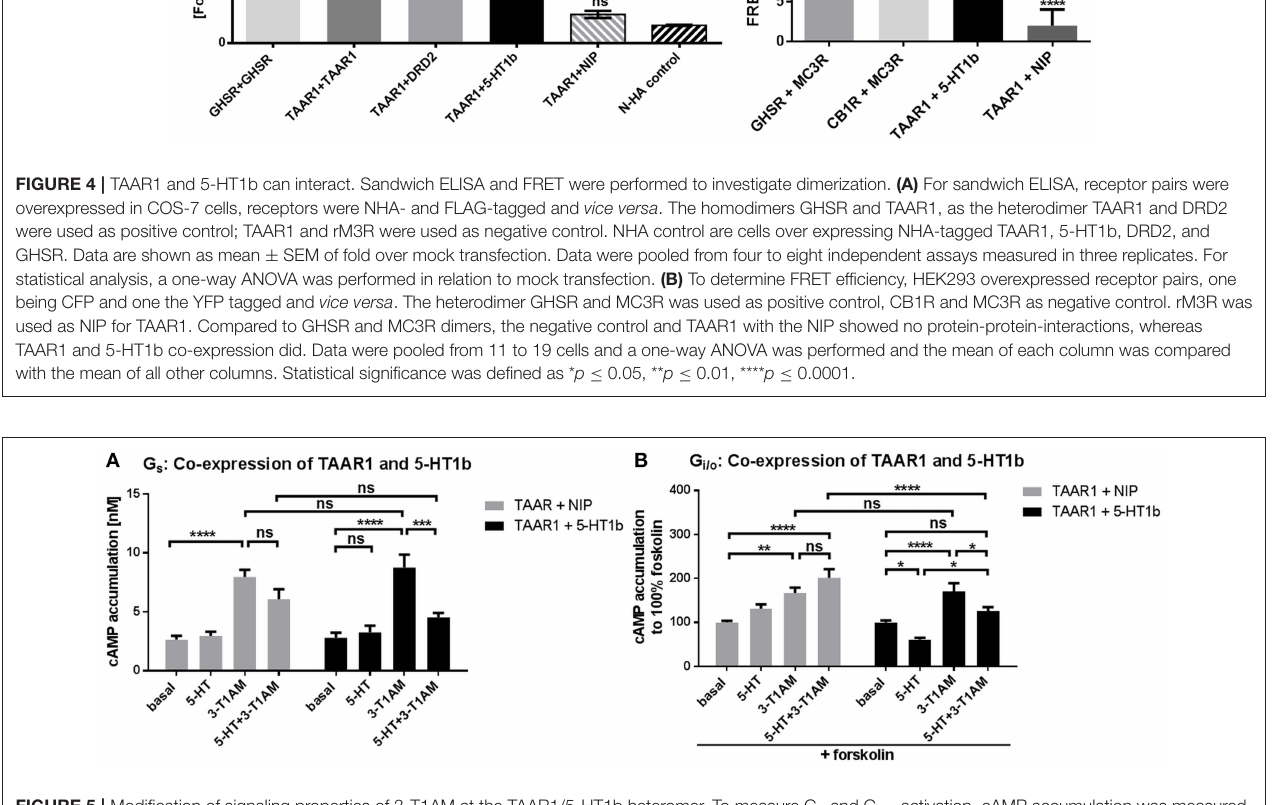
FIGURE 5 | Modification of signaling properties of 3-T1AM at the TAAR1/5-HT1b heteromer. To measure G s and G i / o activation, cAMP accumulation was measured via an AlphaScreen technology. For control, HEK293 expressing TAAR1 and a non-interacting protein (MC3R) were used (gray bars) and compared with TAAR1 and 5-HT1b co-expression (black bars). 3-T1AM does not induce G i / o activation in the heteromeric constellation and the effect of 5-HT is lessened. Data were pooled from 6 to 10 independent assays and measured in triplicates. For statistics, a one-way ANOVA was performed to compare the ligands, a two-way ANOVA was used to compare TAAR + NIP and TAAR + 5-HT1b and considered significant with * p ≤ 0.05, ** p ≤ 0.01, *** p ≤ 0.001, **** p ≤ 0.0001. (A) Cells were stimulated with either 5-HT, 3-T1AM or both in a concentration of 10 µ M. (B) For G i / o , cells were additionally co-stimulated with forskolin and the